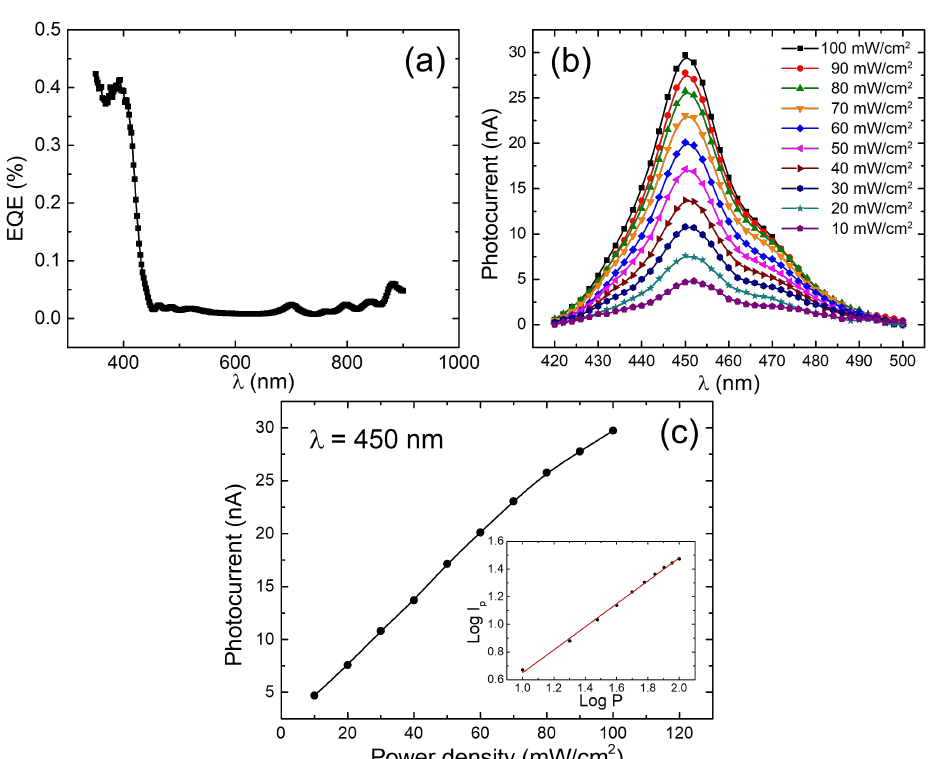
Figure 6. ( a ) The action spectrum of the Au/ZnTe/ZnSe/ZnO/ITO “sandwich” structure at AM 1.5 illumination condition; ( b ) photo-sensibility test of the present structure between 100 mW/cm 2 and 10 mW/cm 2 incident wavelength intensity; ( c ) maximum sensitivity photocurrent ( I p ), taken at λ = 450 nm, represented as a function of the power of the incident light. The inset: corresponding log-log representation of the photocurrent versus power density with a sub-unitary slope of the linear regression ( k =